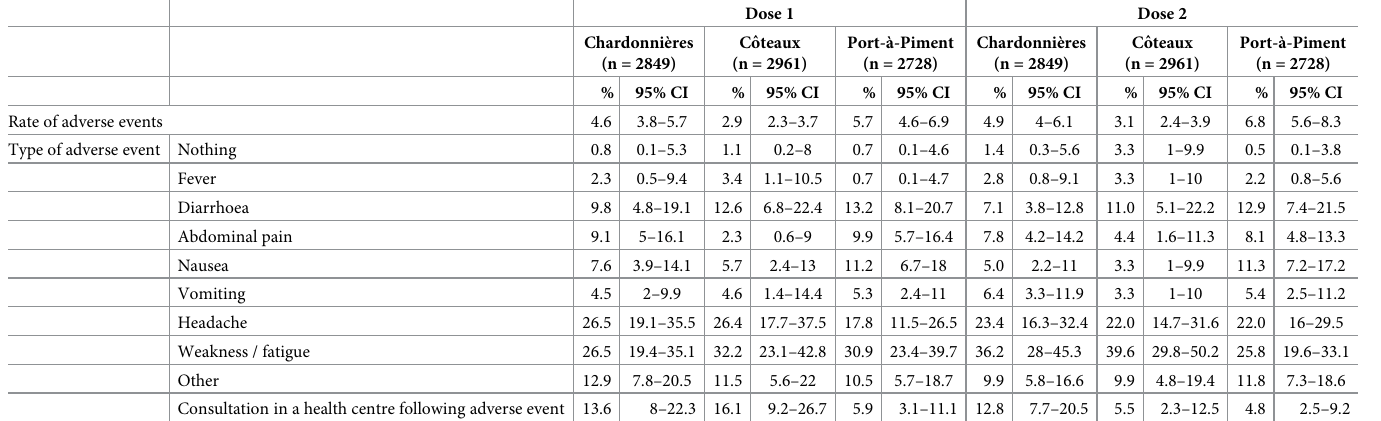
Table 2. Adverse events reported by dose and Commune, South Department, Haiti,